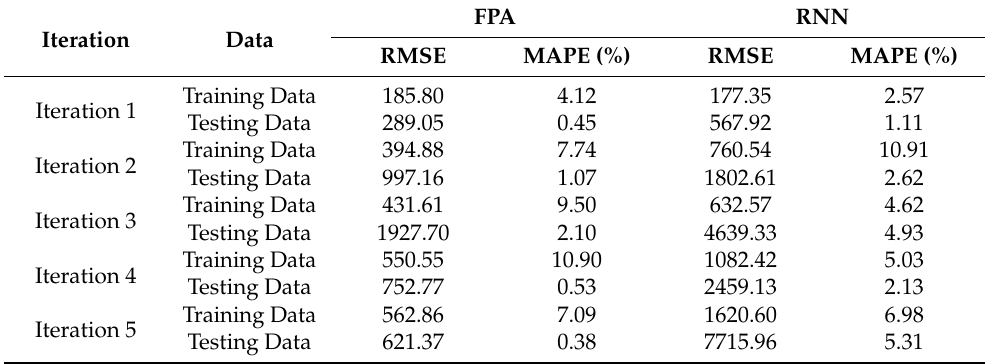
Table 5. Long-term forecasting results.